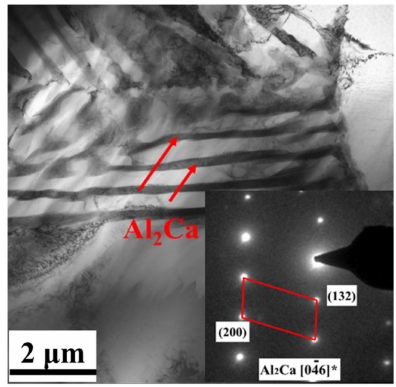
Figure 3. Transmission electron microscope (TEM) micrograph of the eutectic structure and the corresponding selected area electron di ff raction (SAED) pattern of the black lamellar